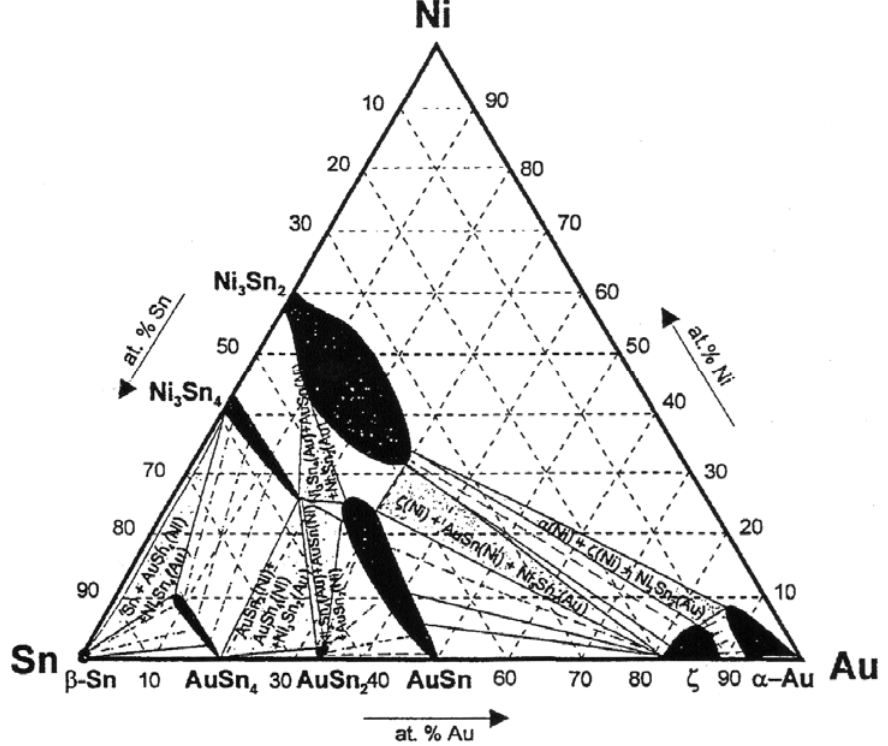
Figure 23. Isothermal section of the Au-Ni-Sn system at room temperature [60] ( © 1998